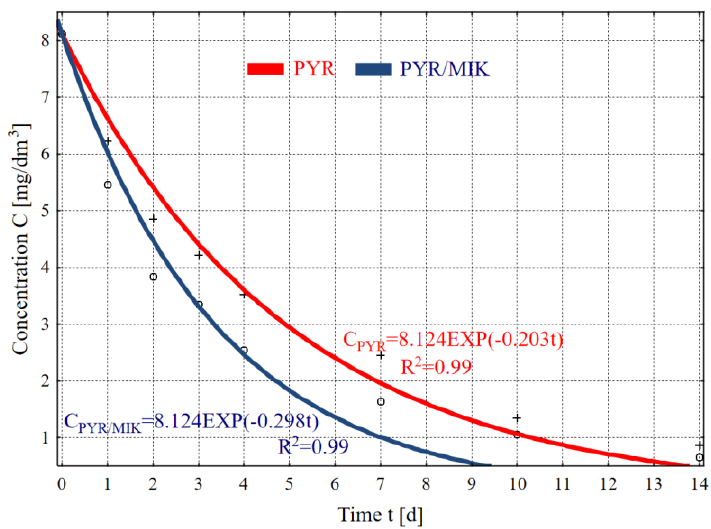
Table 7. Values of the coefficients of the equations of the dynamics of disappearance of pyra- clostrobin with and without the addition of microorganisms (MK), half-life times of pesticides in DT 50 wastewater and theoretical times to reach concentrations of 0.05 and 0.01 mg/L.